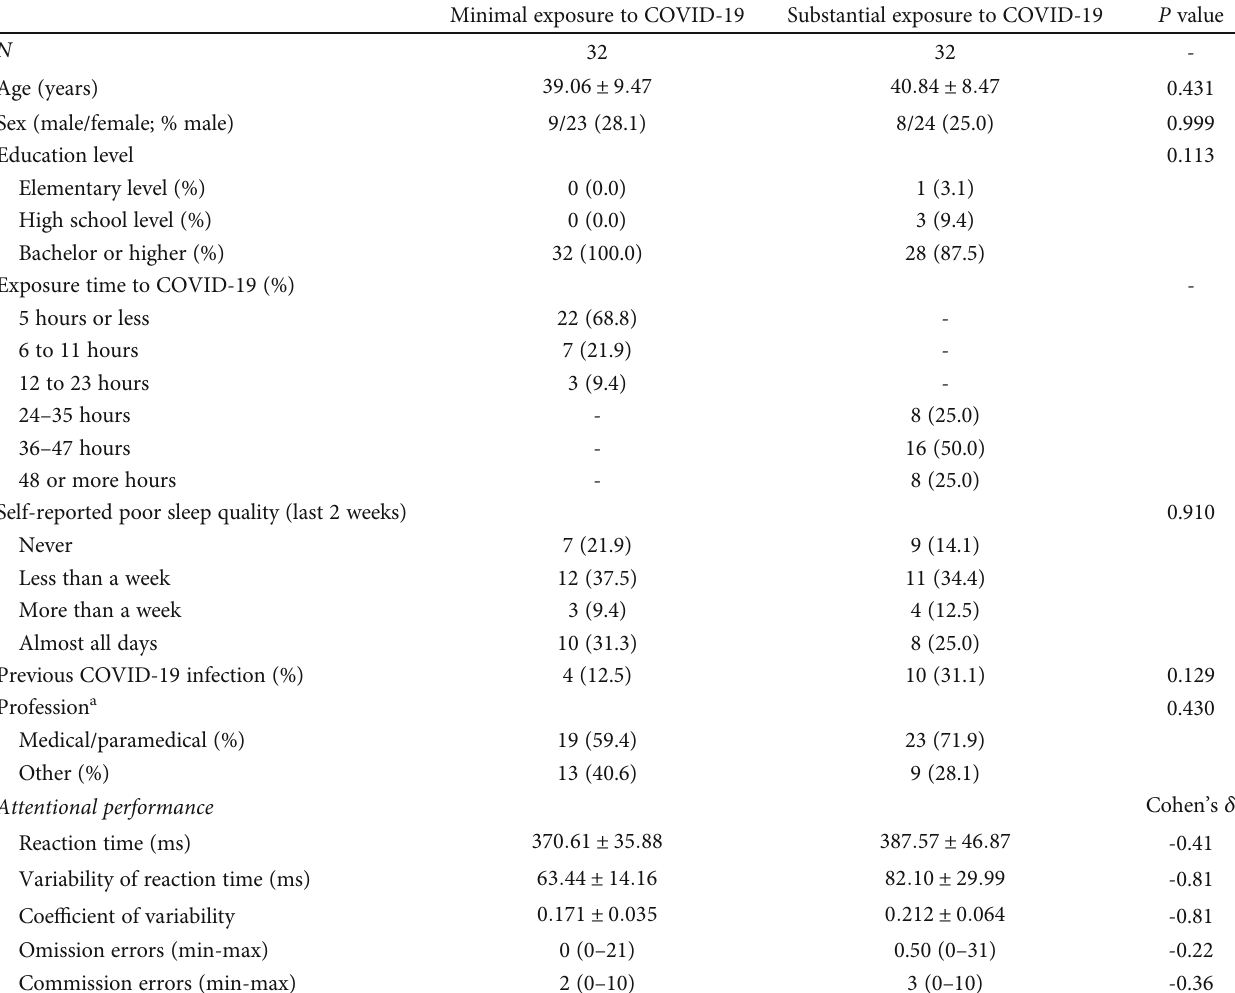
Table 2: Group characteristics of the matched